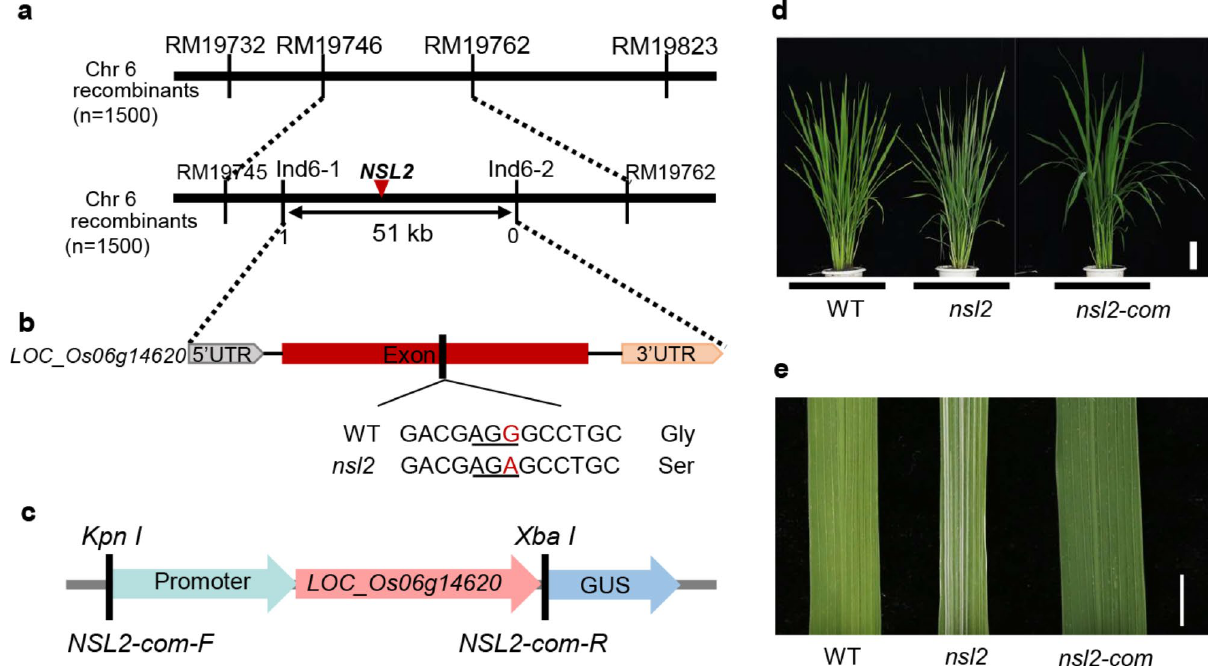
Fig. 3 Map-based cloning of NSL2 . a : Primary and fine mapping of the NSL2 gene on chromosome 6. The NSL2 locus was narrowed to a 51-kb region. b : The structure of candidate gene and mutation site. c : Structure of the NSL2 complementary vector. d and e : Phenotypes of the NSL2 gDNA complemen- tation lines. Bars ( d ) 10 cm; ( e ) 1